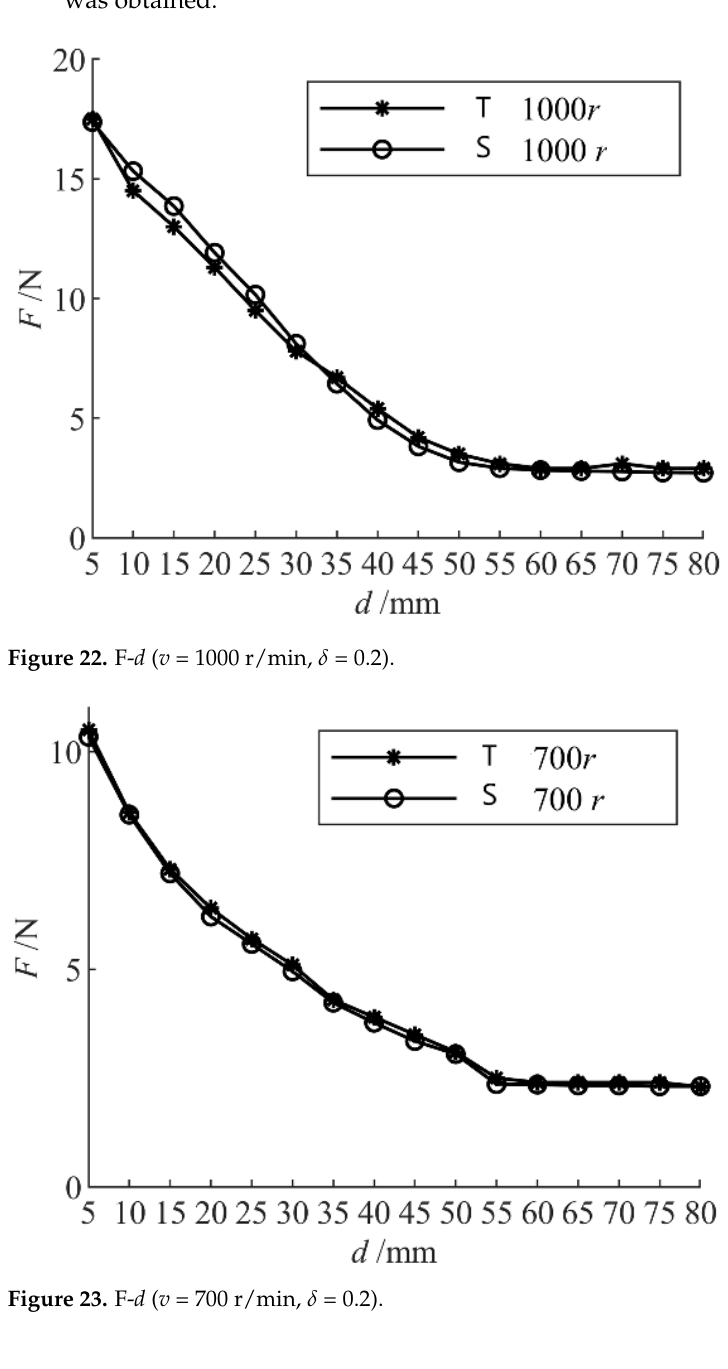
Figure 24. F- d ( v = 500 r/min, δ = 0.2). A comparison of the results of the numerical simulations and the prototype experi- ment shows that they were consistent, which verifies the correctness of the theoretical analysis and the numerical simulations. The following can be concluded: (1)